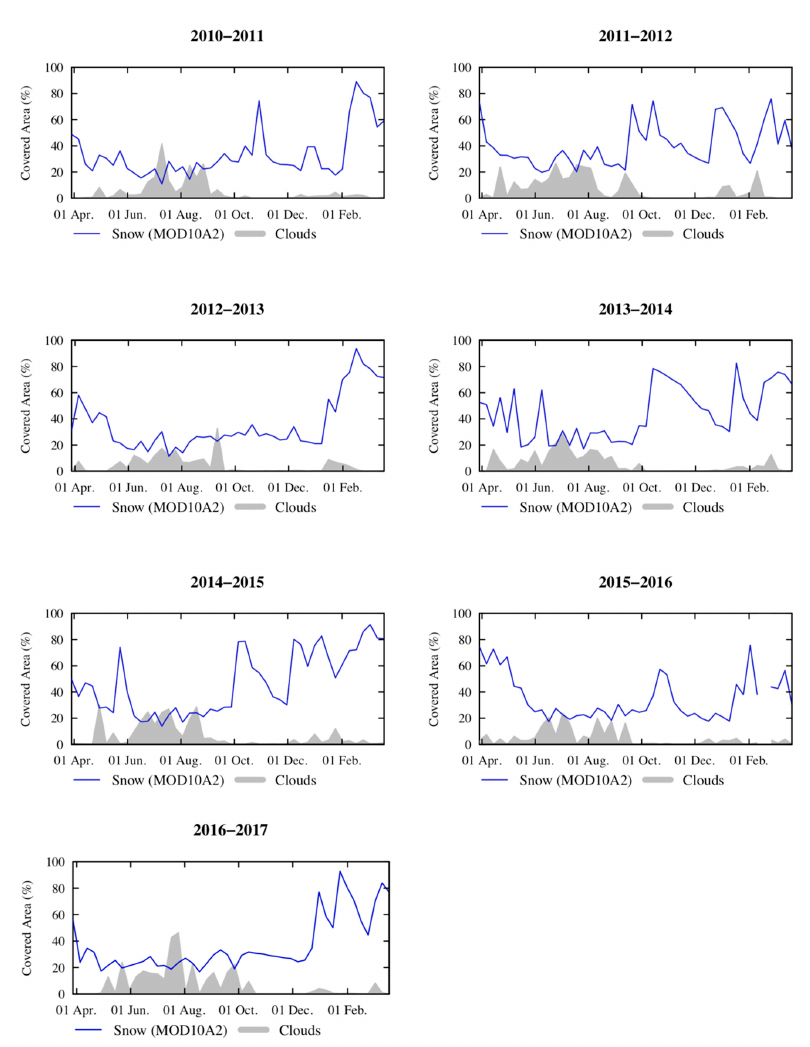
Figure A1. Yearly SCA statistics for the Dudh Koshi basin (1998–2017).